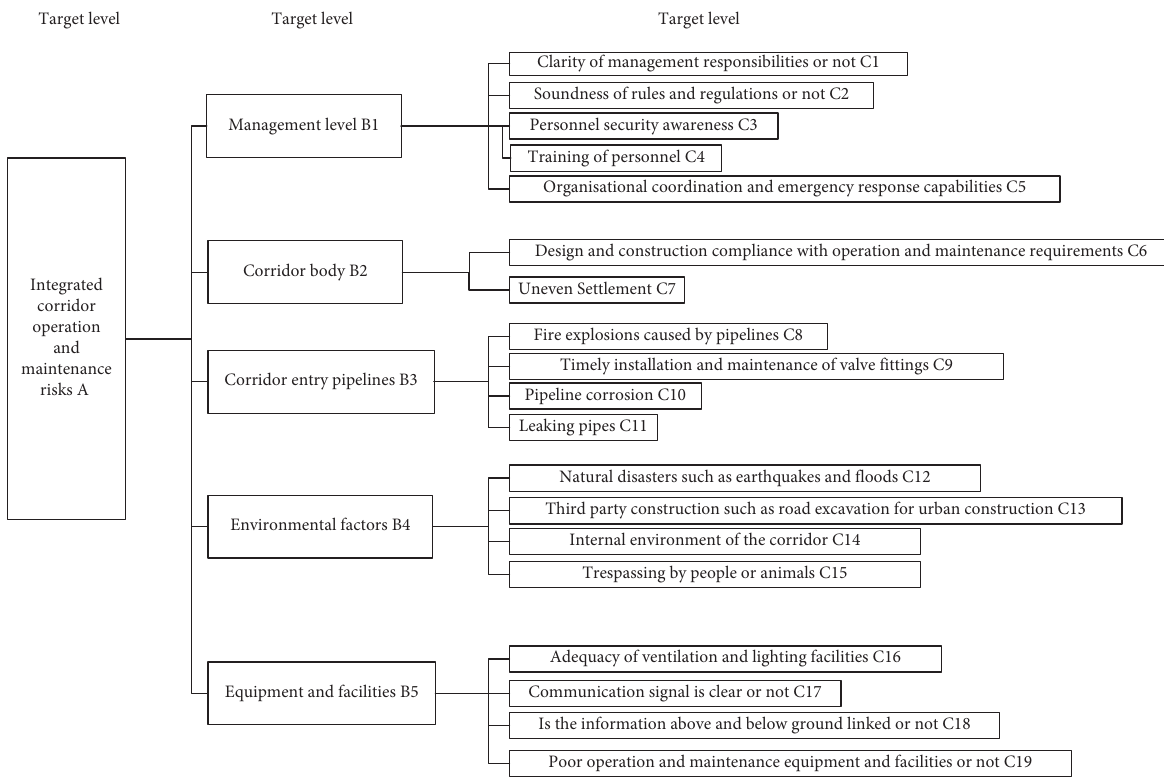
Figure 3: Integrated corridor operation and maintenance risk evaluation index system. Table 4: Comparison matrix of risk factors for criterion level